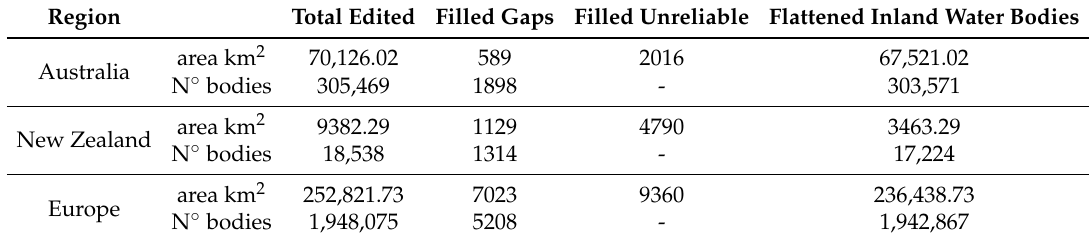
Table 2. Editing summary